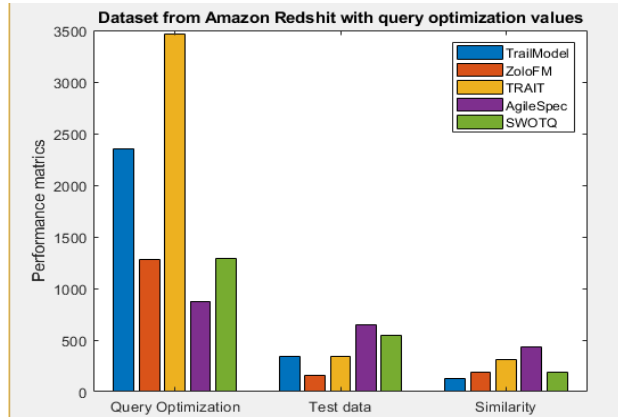
Figure 3. The dataset from Amazon Redshit with query optimisation values